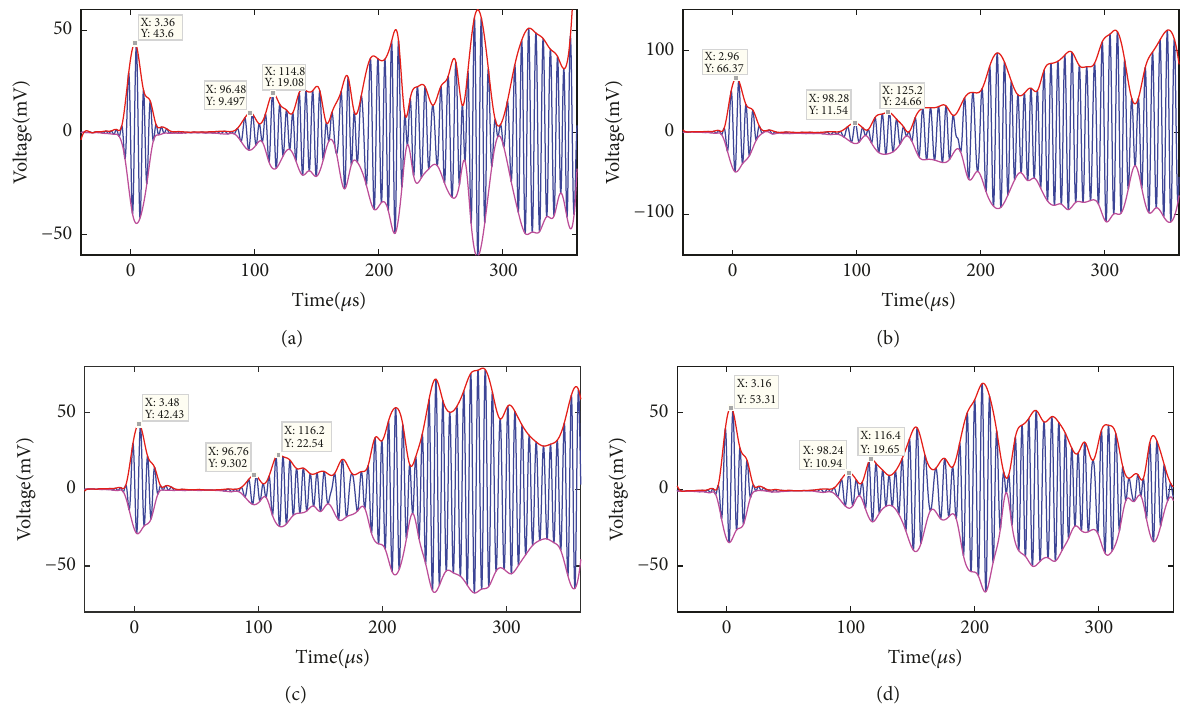
Figure 12: Collected signals of piezoelectric transducers after filtering (a) no. 1, (b) no. 2, (c) no. 3, and (d) no. 4 when the cracked rotor is at rest.